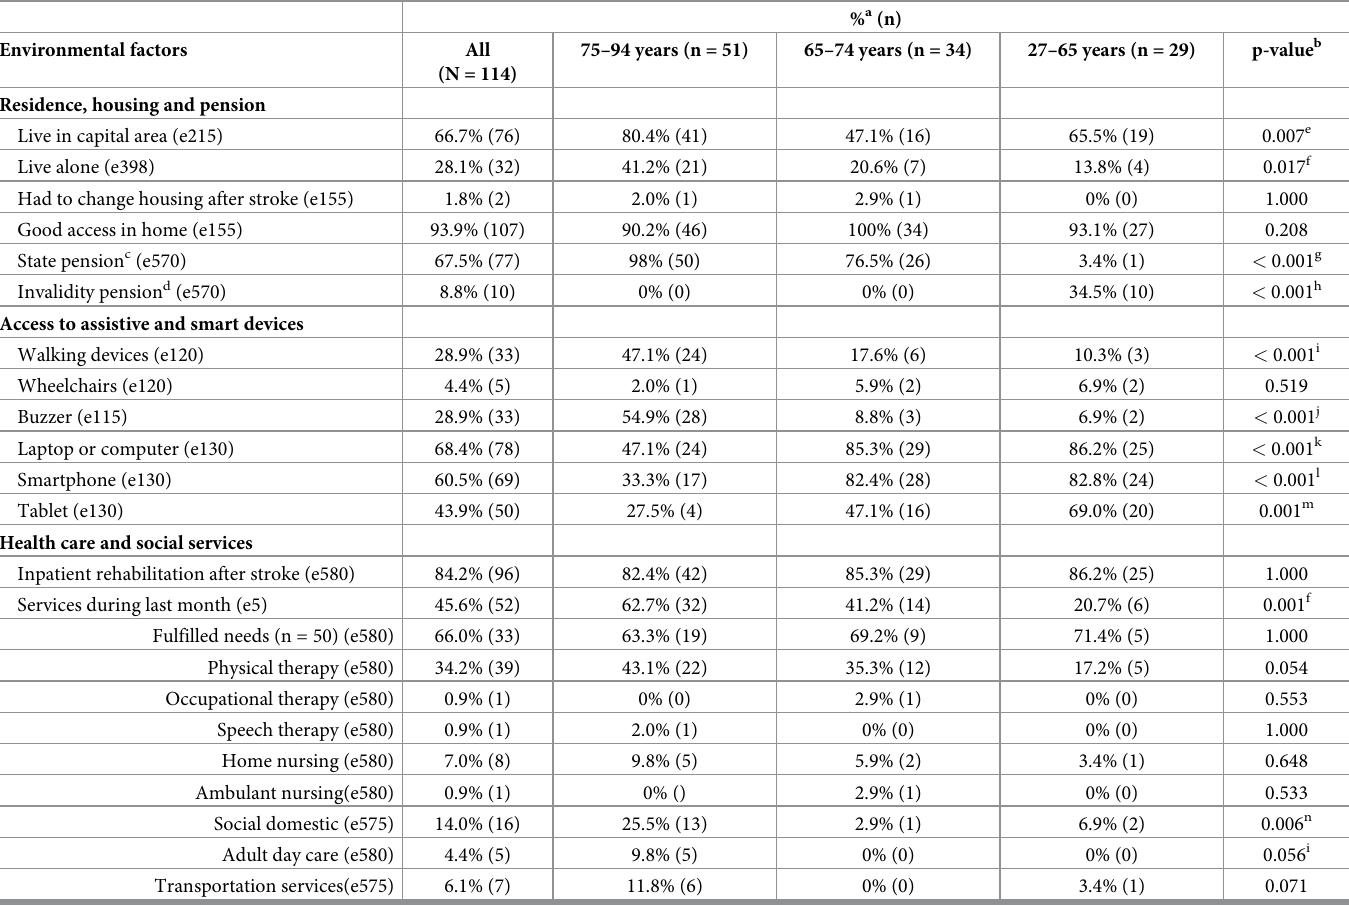
Table 2. Survey items linked to the ICF component of environmental